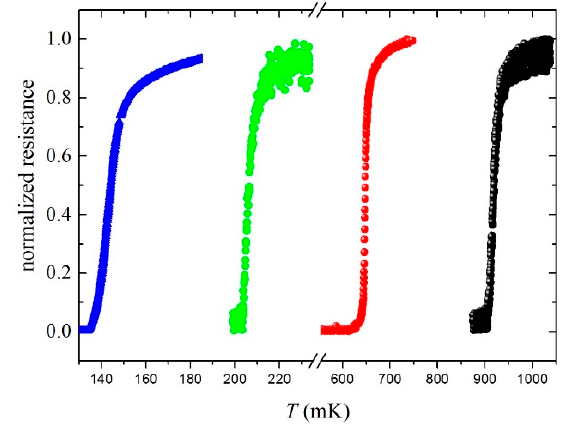
Figure 1. Critical temperatures of different Al/Ti transition-edge sensors (TESs) ranging between 0.14 K and 1 K.